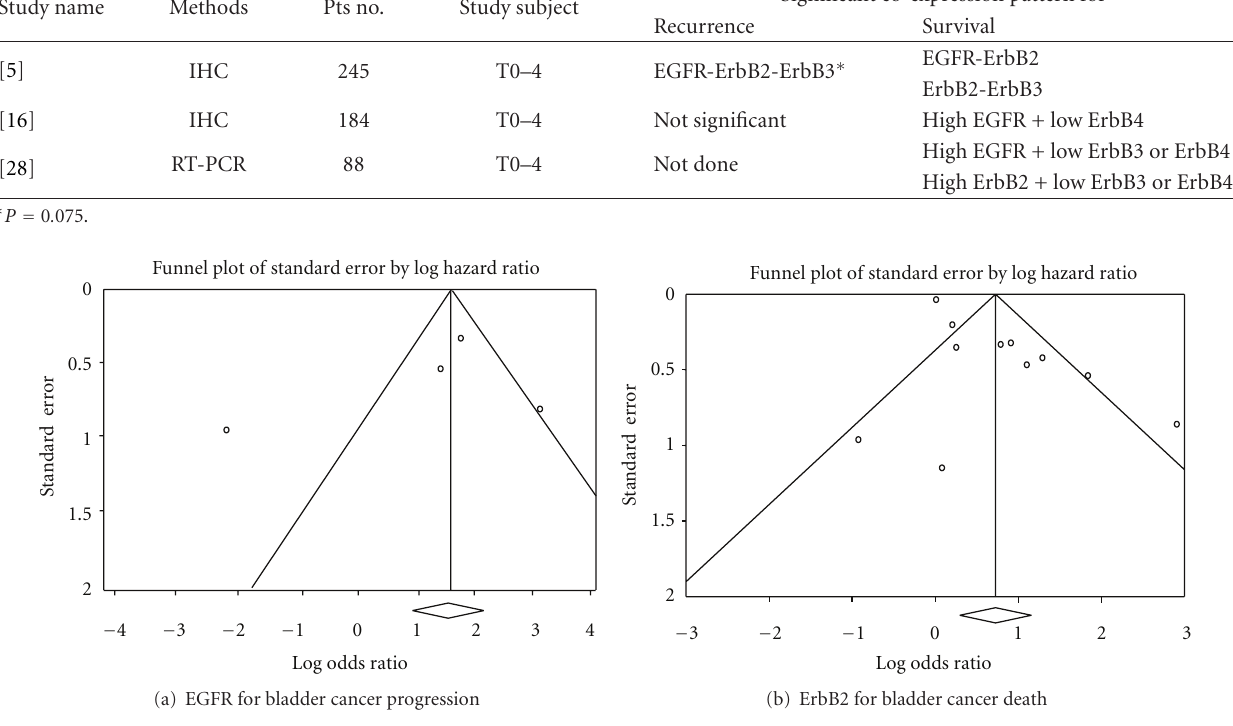
Figure 3: Funnel plots of publication bias for EGFR and ErbB2. (a) No obvious funnel plot asymmetry was found for EGFR because only four studies were analyzed. (b) A substantial funnel plot asymmetry for ErbB2 was found, which suggests the existence of publication